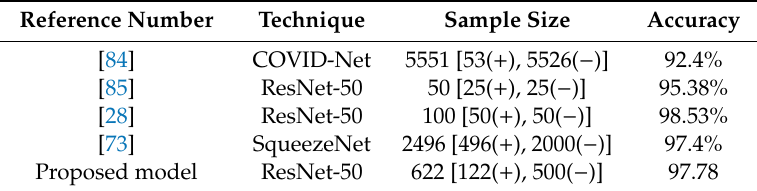
Table 7. Comparison with other classification